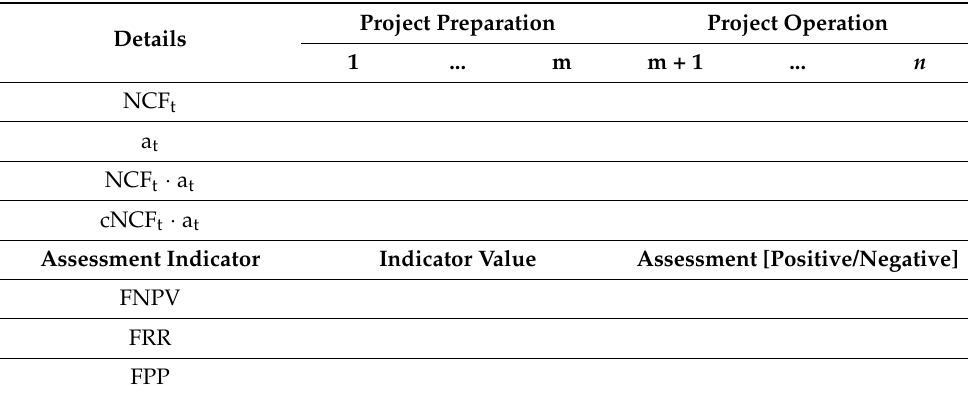
Table 6. Results of the evaluation of the financial effects of the project implementation. Source: designed by authors.